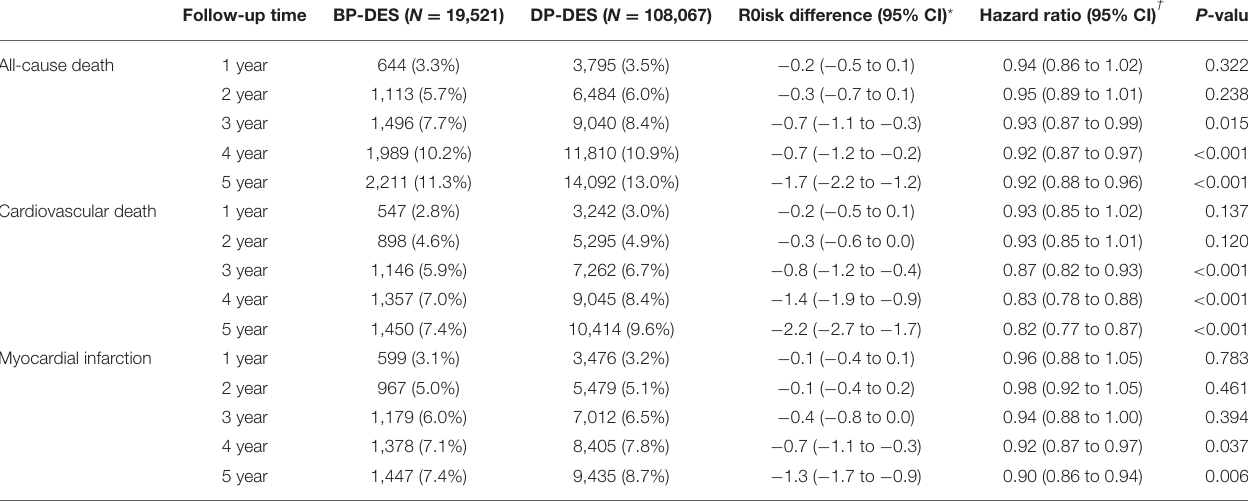
TABLE 2 | Risk of clinical outcome between biodegradable and durable polymer DES after stabilized inverse probability of treatment weighting. Follow-up time BP-DES ( N =